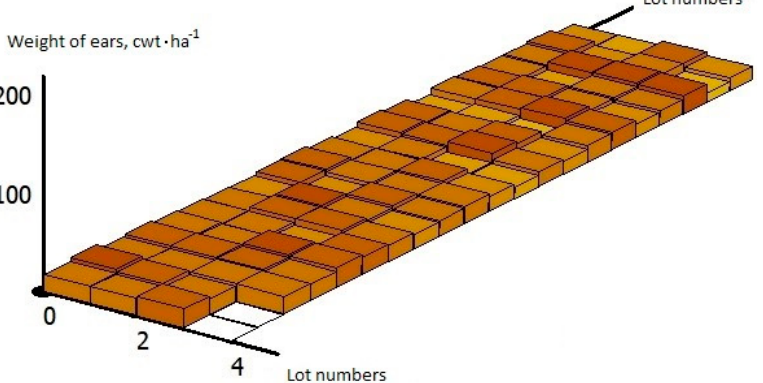
Figure 13. Distribution of the estimates of the weight of ears of spring wheat sowing by elementary areas of the field.